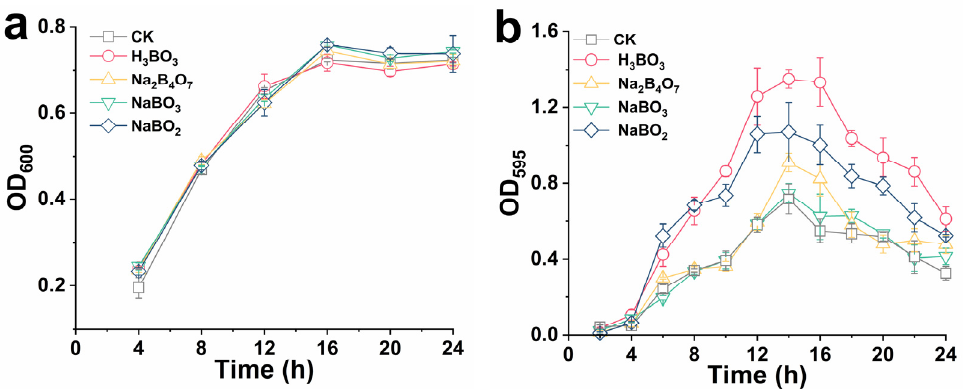
Figure 2. Effects of boron derivatives types on the growth curve ( a ) and E. coli biofilm formation ( b ). Culture conditions: ( a ) the concentration of boron derivatives was 0.6 mM, the culture temperature was 37 °C, and the rotation speed was 220 rpm; ( a ) the concentration of boron derivatives was 0.6 mM, the culture temperature was 37 °C and the biofilm was cultured in a 24-well plate.